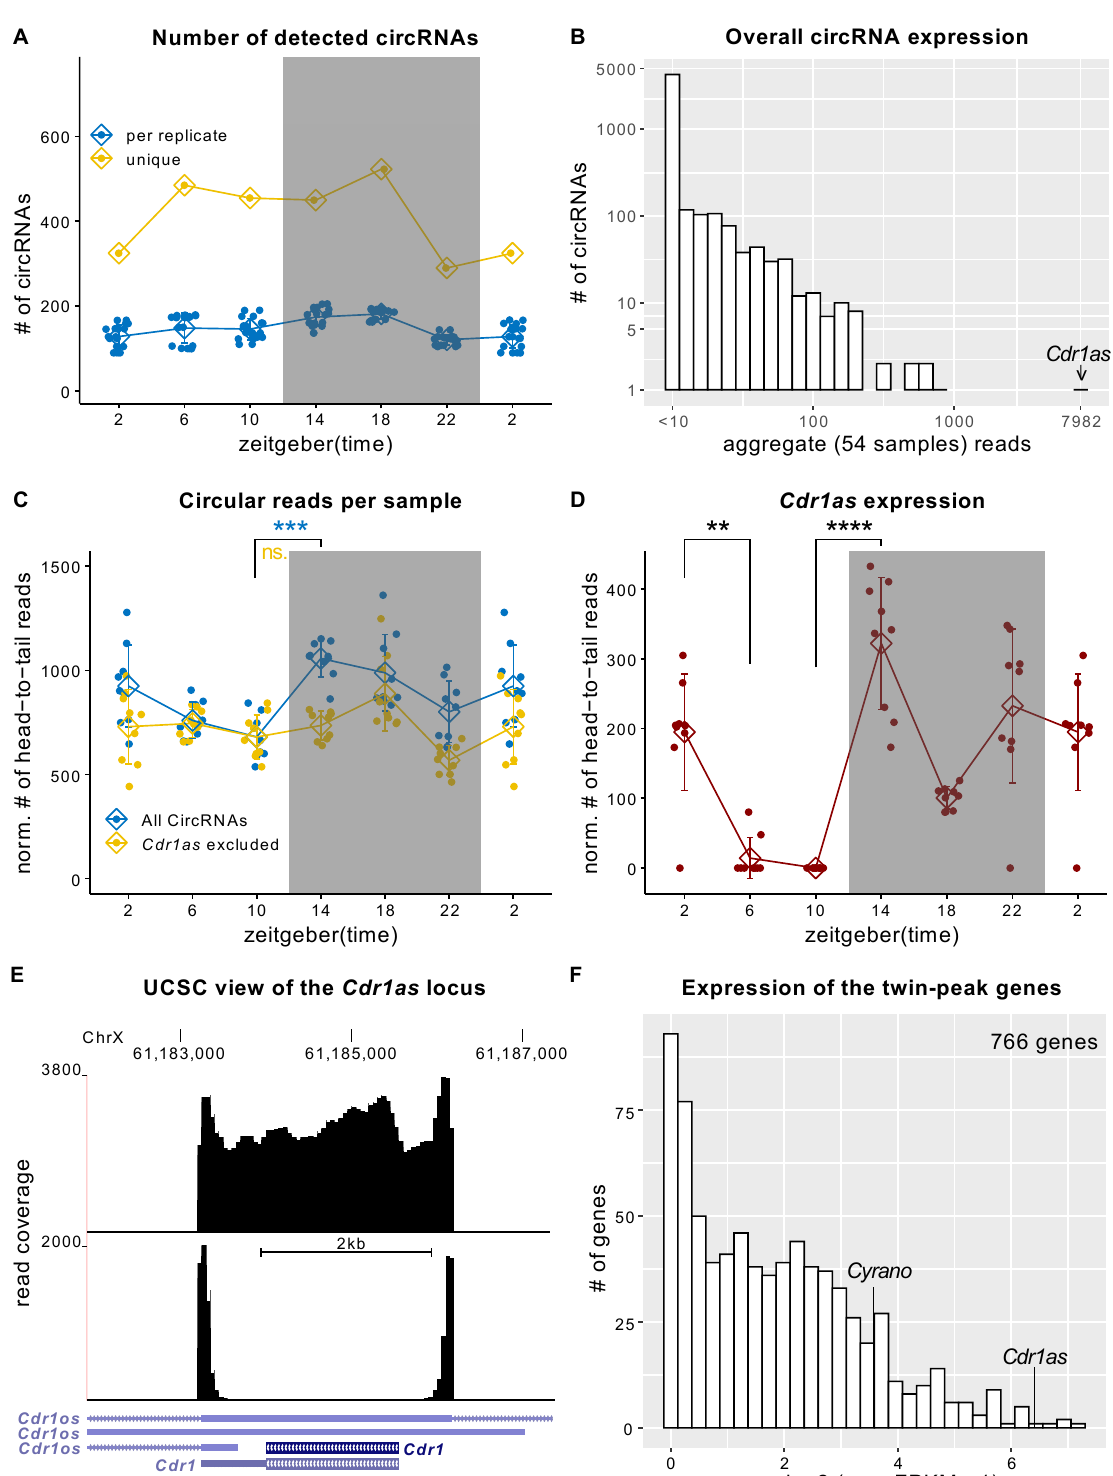
Figure 1. Cdr1as expression changes during the 24 h LD cycle in the SCN. ( A ) The number of detected circRNAs for each replicate and each time point. ( B ) Overall expression of circRNAs. For each circRNA, we summed up circularization-supporting head-to-tail reads in all samples/groups. Cdr1as has an order of magnitude higher expression than any other circRNA. ( C ) Normalized (to the number of mapped reads) circular reads in the 12:12 LD cycle. Error bars show the SD. (Bonferroni) Adjusted t -test p -value: *** < 10 −5 , ns is not significant ( D ) Normalized expression of Cdr1as circRNA during the 12:12 LD cycle. Error bars show SD. DESeq-2 adj. p -value: ** < 10 − 3 . **** < 10 − 16 . ( A – D ) use periodic continuation plotting at ZT2. ( E ) UCSC genome browser view of the Cdr1